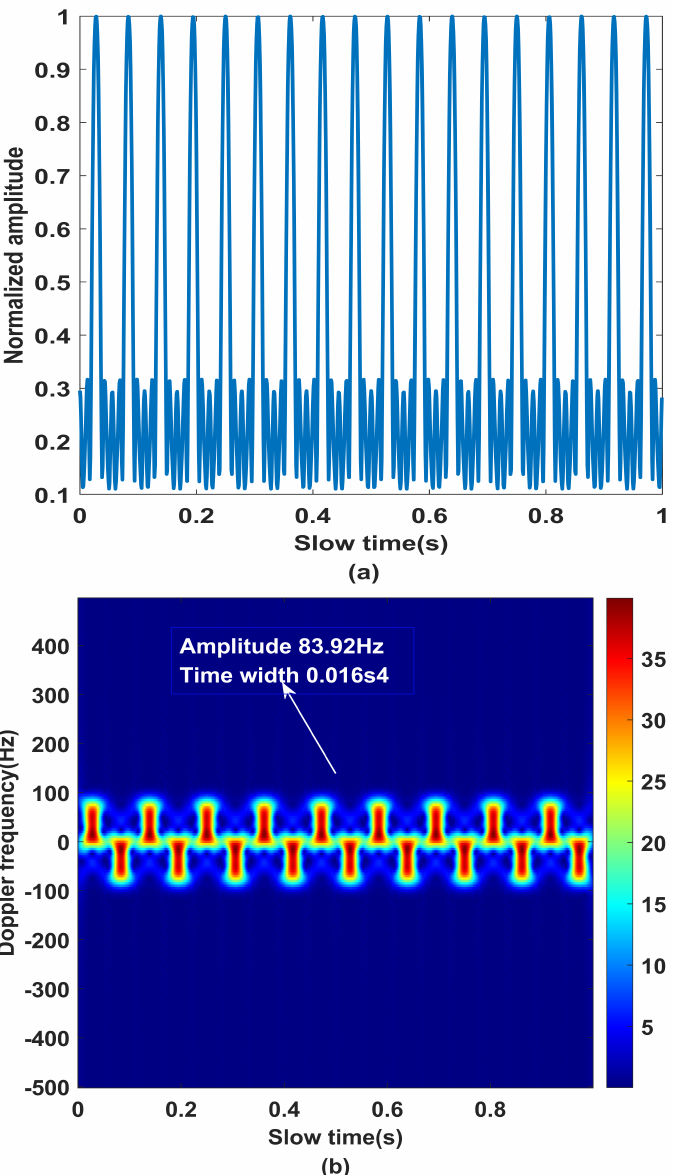
Figure 6. Echo signals of rotating target: ( a ) echo signal in the slow time domain and ( b ) echo signal in the time-frequency